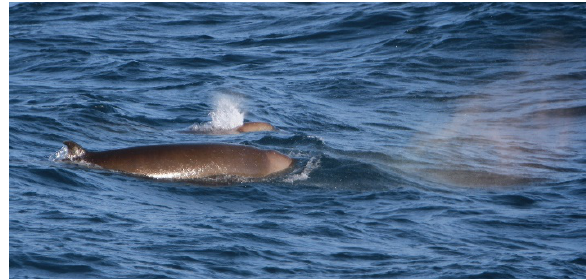
Figure 9. Northern bottlenose whales. Photo credit: Natural History Museum, Faroe Islands. Northern bottlenose whales are extreme deep divers, reaching depths approaching 1,500 m and with dive durations of 70 minutes or more (Hooker & Baird, 1999). They also undertake shorter, shallower dives in addition to deep feeding dives. In all, they may spend 60% to 70% of their time beneath the